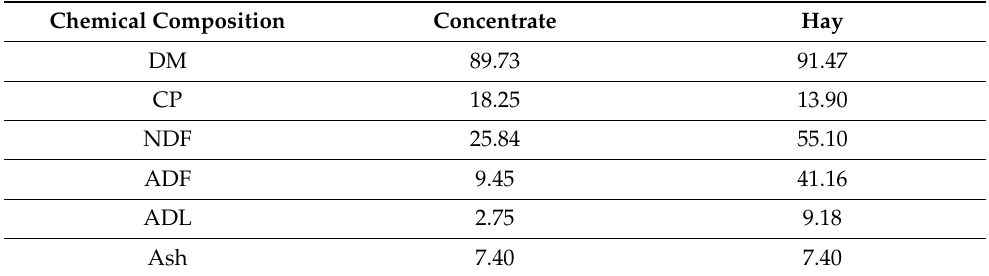
Table 1. Chemical composition of concentrate and hay (% on a DM basis) used during the trial. Chemical